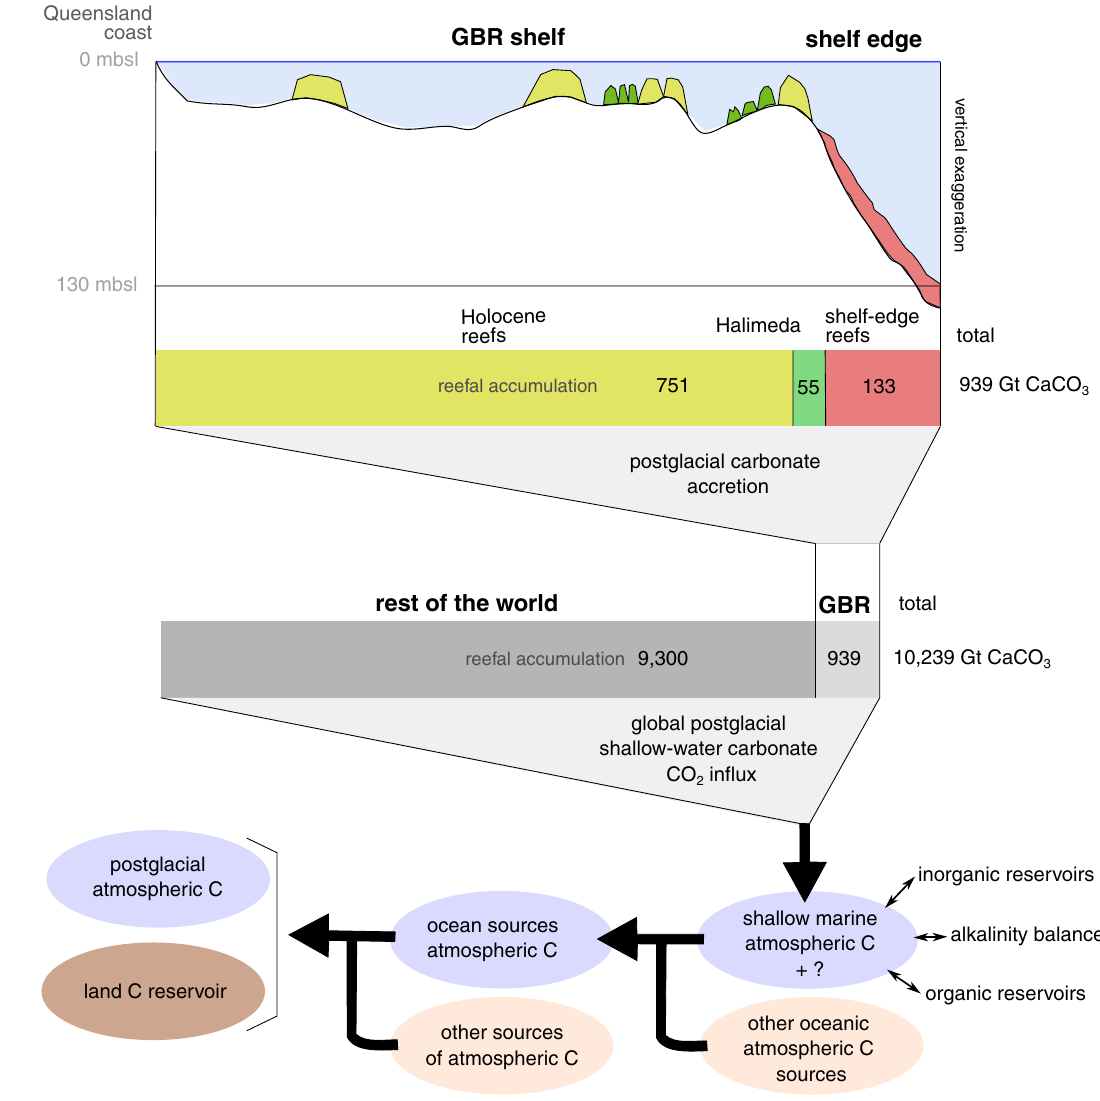
Figure 6. Summary of CaCO 3 volumetrics by formation, and comparison between global and GBR regional deposits. The postglacial reefs and Halimeda deposits participate in the global carbon cycle by changing the alkalinity of the shallow ocean, affecting CO 2 solubility and eventually provoking an influx of CO 2 to the